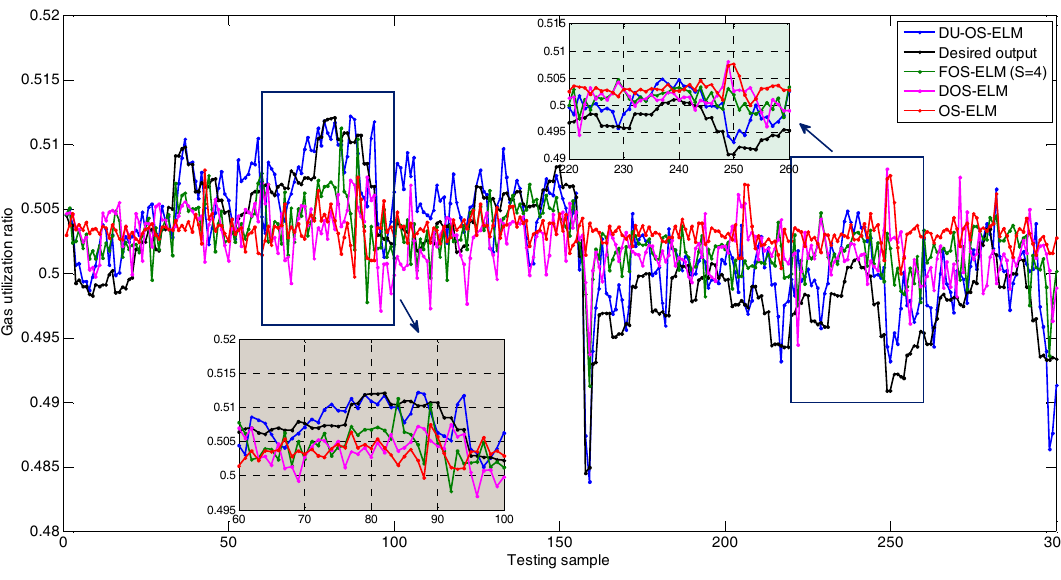
Figure 9. λ k by DOS-ELM and DU-OS-ELM.  by DOS-ELM and DU-OS-ELM. Figure 9. k